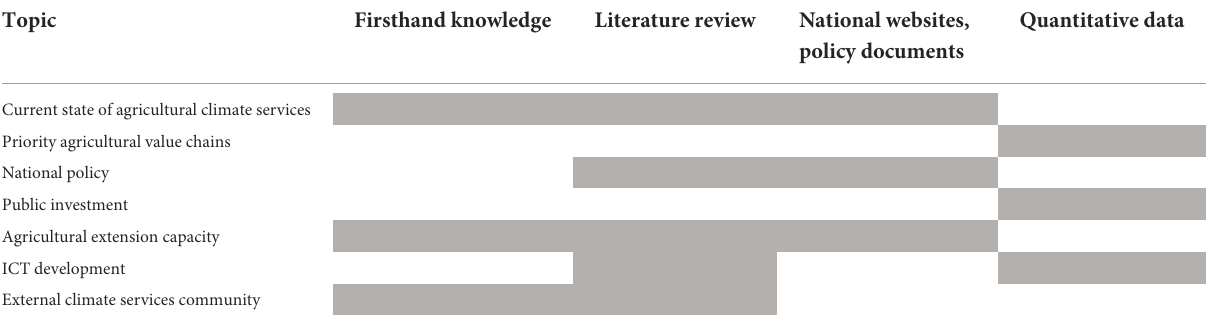
TABLE 1 Information sources used for each study topic (indicated by grey shading).